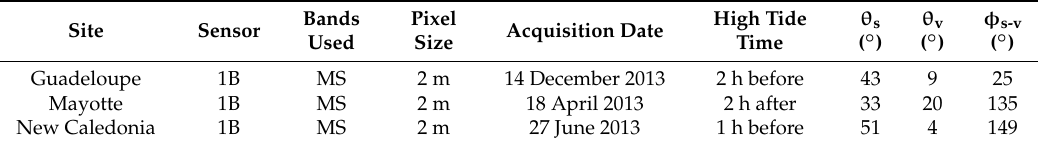
Table 2. Main acquisition parameters of multispectral (MS) Pleiades satellite images. θ s and θ v are the zenithal sun and viewing angles, respectively, while φ s-v is the sun-sensor absolute difference azimuthal angle.